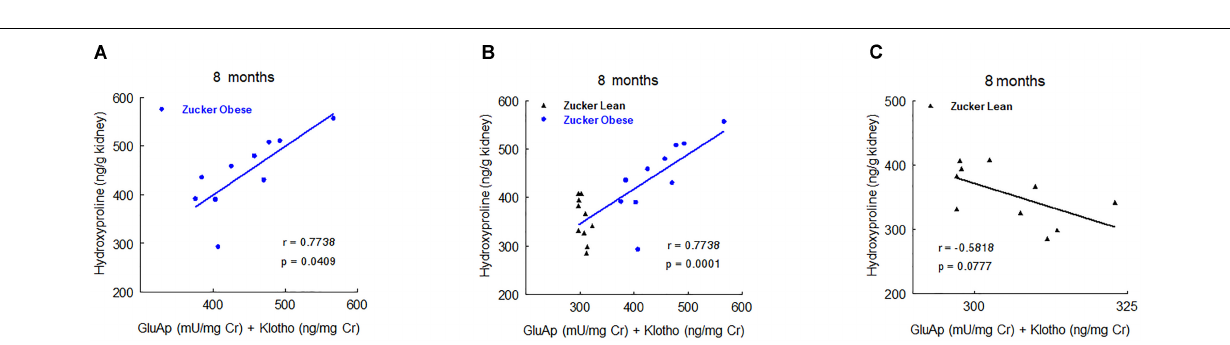
useful tools for the evaluation of obesity induced renal